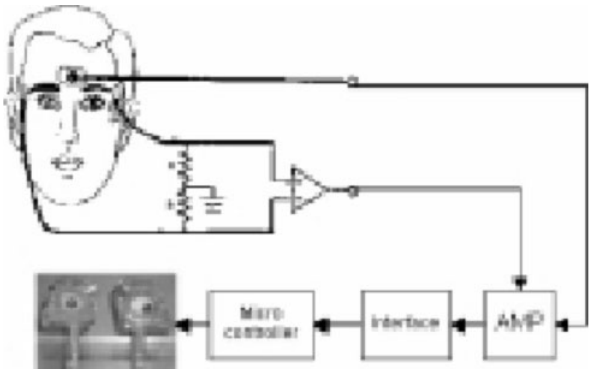
Figure 28 The eye movement detection and ocular system